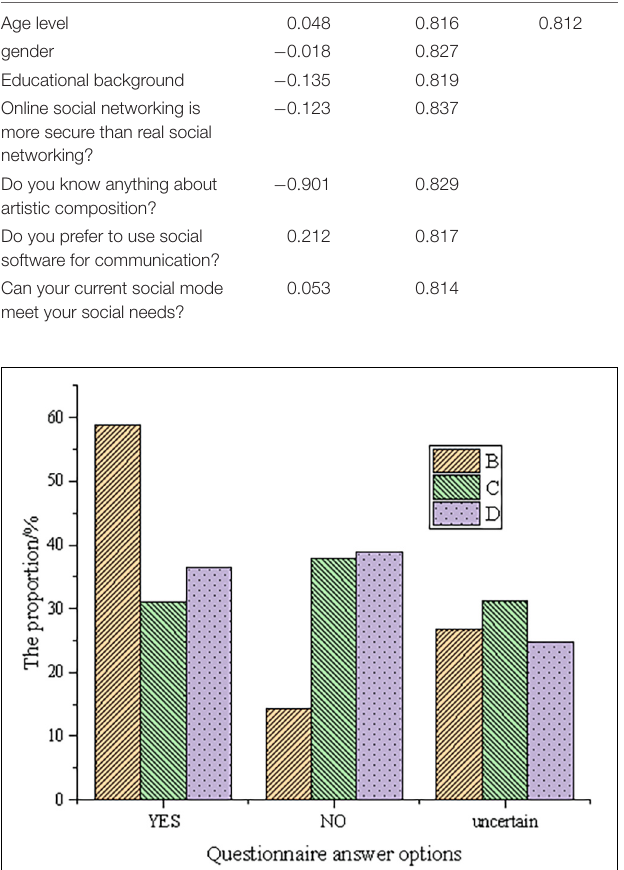
FIGURE 6 | Data of social needs (B, C, and D represent Question B, Question C, and Question D, respectively. Question B: more likely to communicate using social software than face to face. Question C: online socializing is safer than real socializing. Question D: existing ways of social communication can meet social